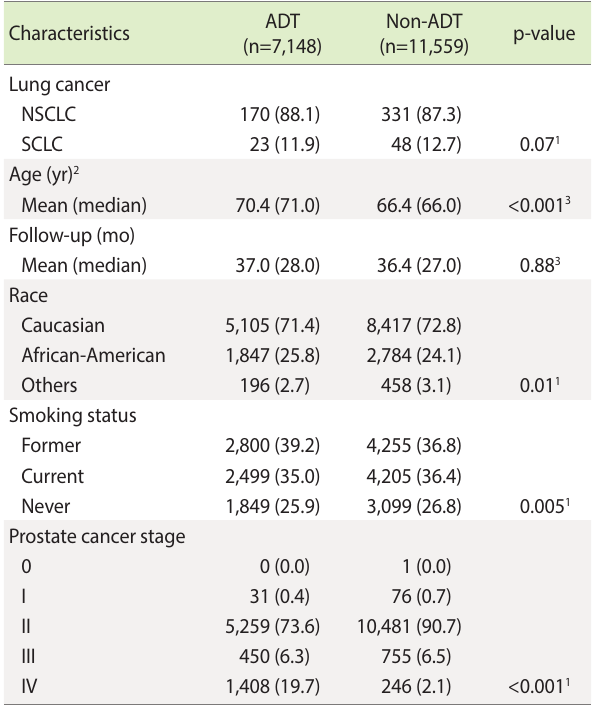
Table 1. Basic characteristics of patients with at least 1 year of fol-